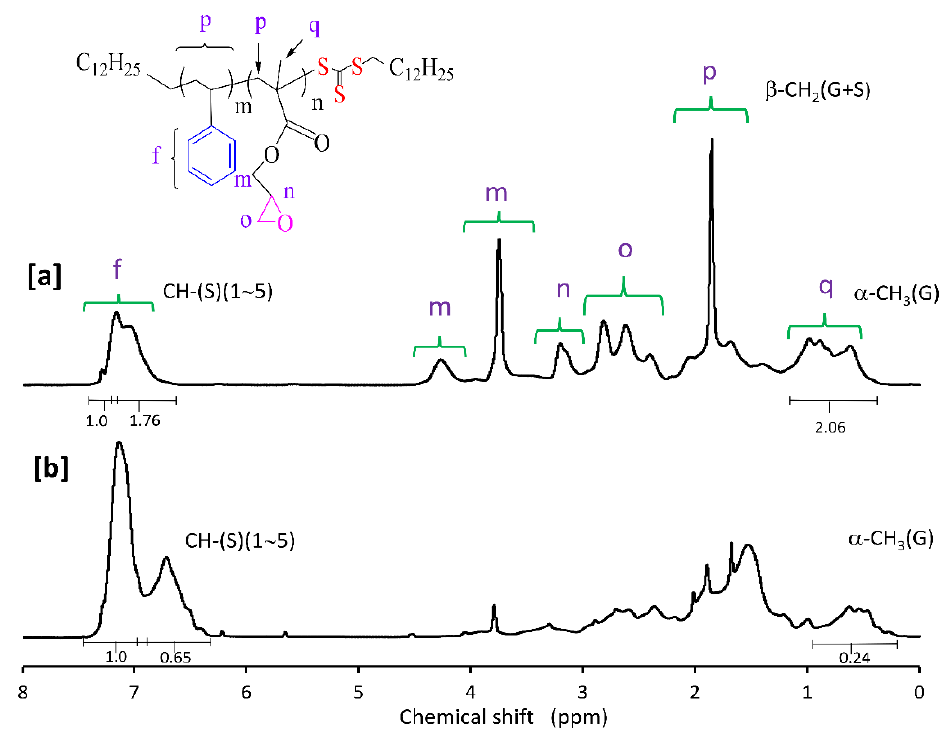
Figure 3. 1 H NMR spectrum of a RAFT synthesized St-GMA copolymer with ( a ) 55% and ( b ) 20% mole fractions of GMA in the feed mixture, using CPDT and ACHN. (f) phenyl protons of styrene; (m, n, o) methylene oxy (–OCH 2 –) protons of GMA; (p, q) methyl protons of GMA.